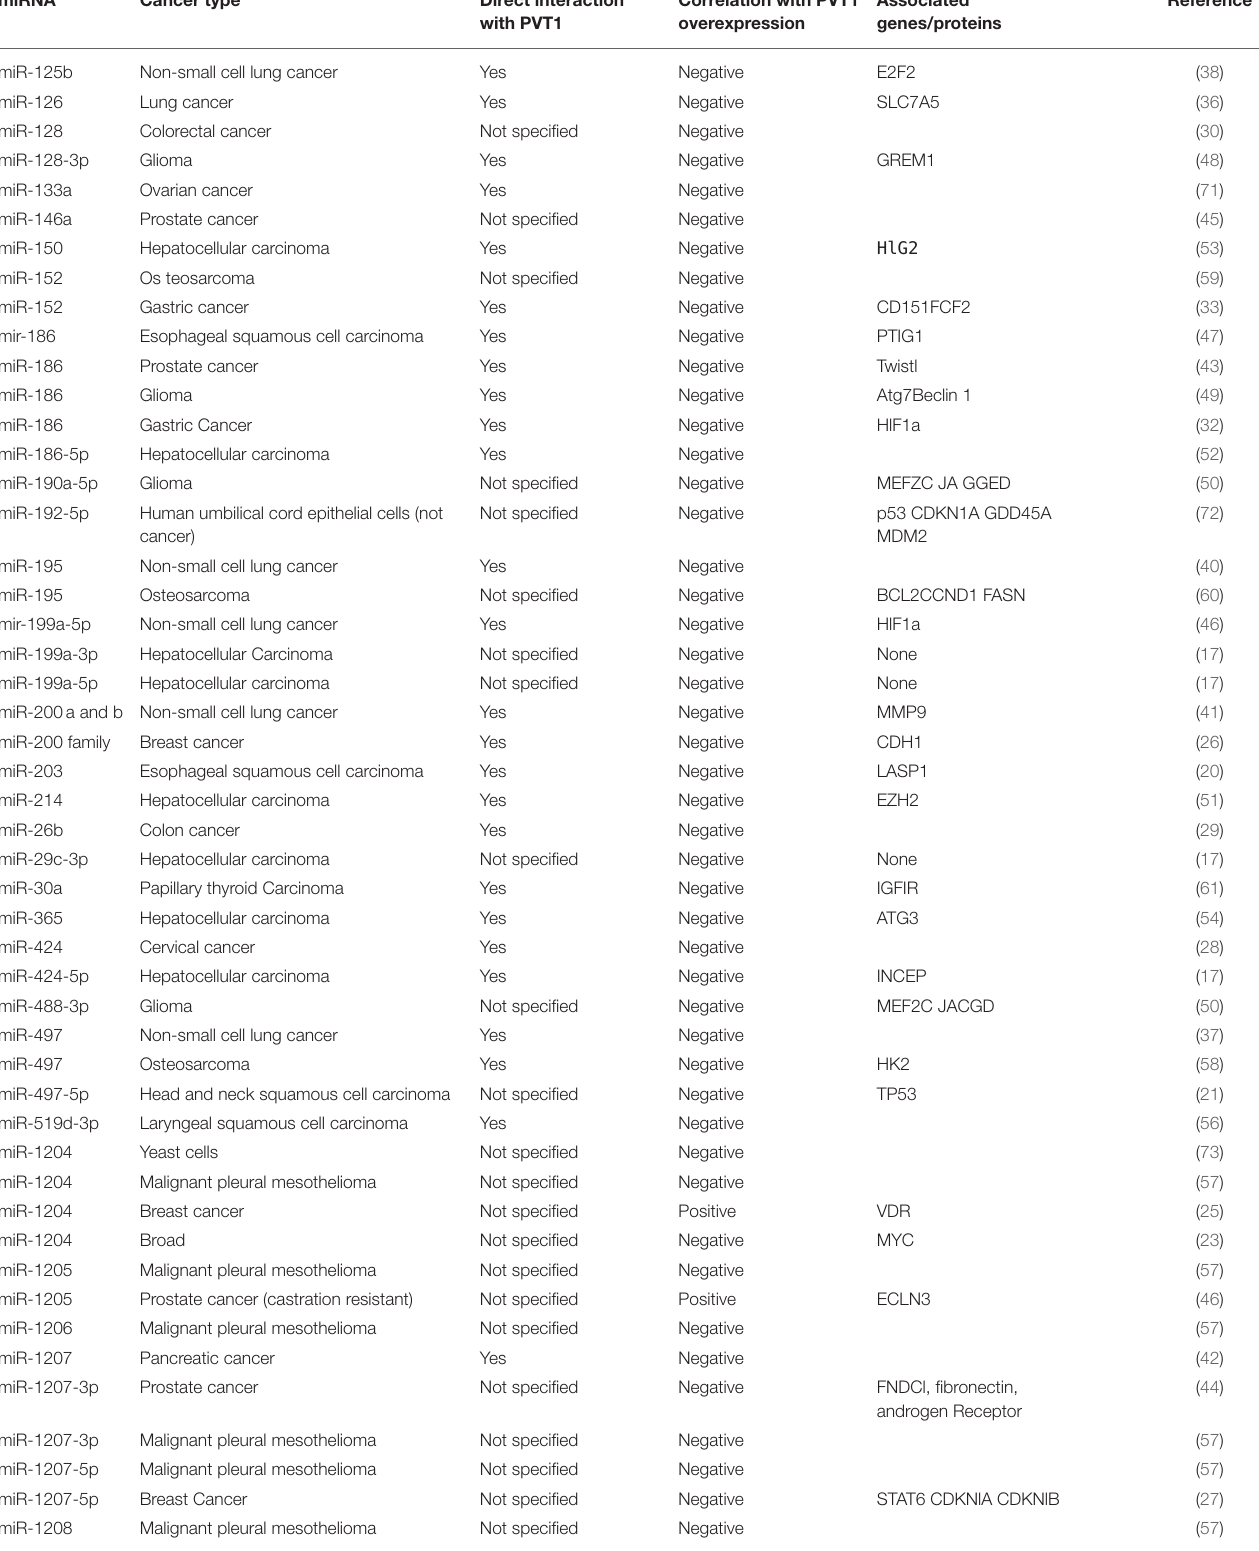
TABLE 1 | miRNAs linked to PVT1 expression and their associated genes and proteins. miRNA Cancer type Direct interaction